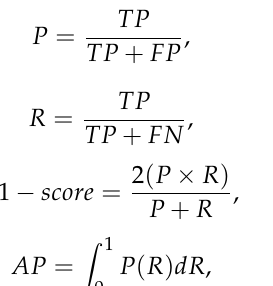
of identified trees, which combines P and R . These indicators range from 0 to 1 with larger values